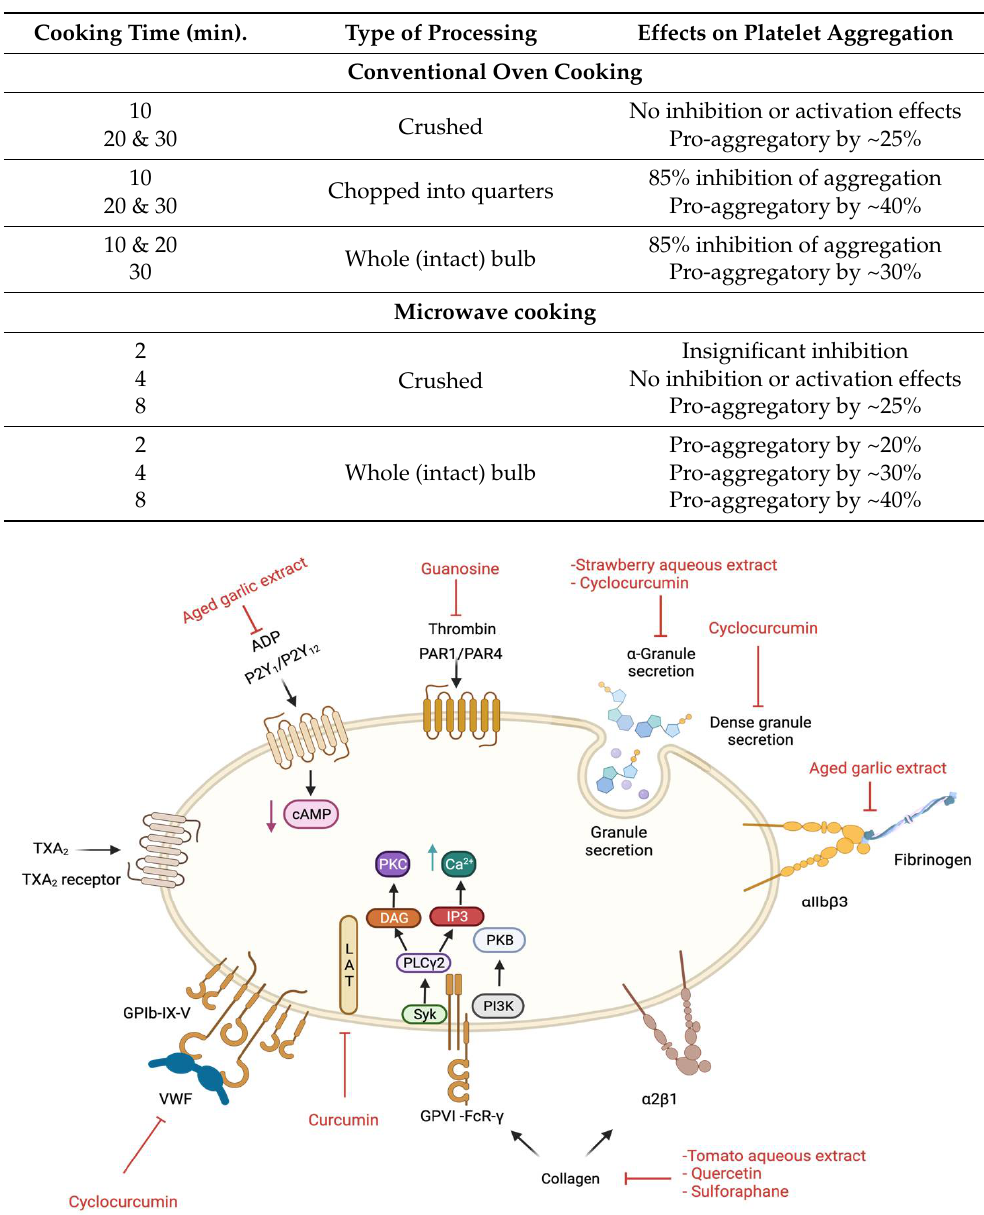
Table 1. The effects of conventional oven and microwave cooking, different preparation methods and cooking time on antiplatelet activities of A. cepa [49]. Cooking Time (min).